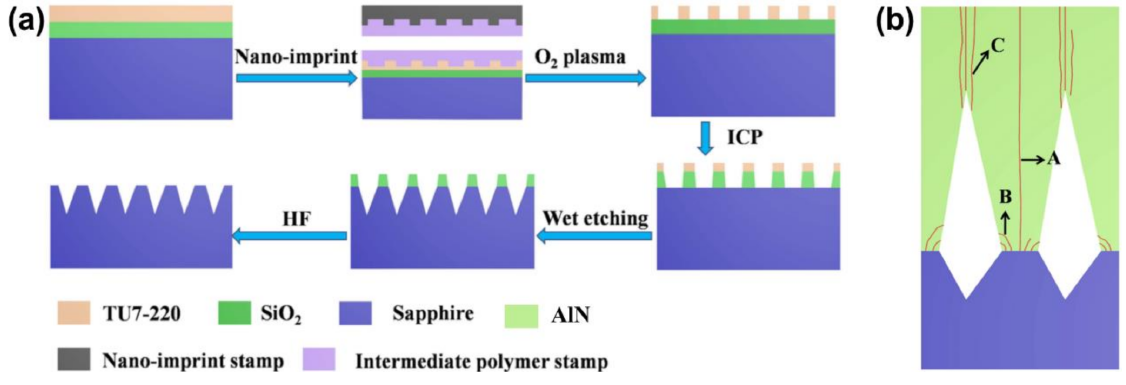
Figure 12. ( a ) Cross-sectional schematic diagram of the NPSS fabrication process flow by nano- imprint lithography; ( b ) dislocation behaviors in ELOG-AlN epilayer. Reprinted from [62] under a Creative Commons Attribution 4.0 International